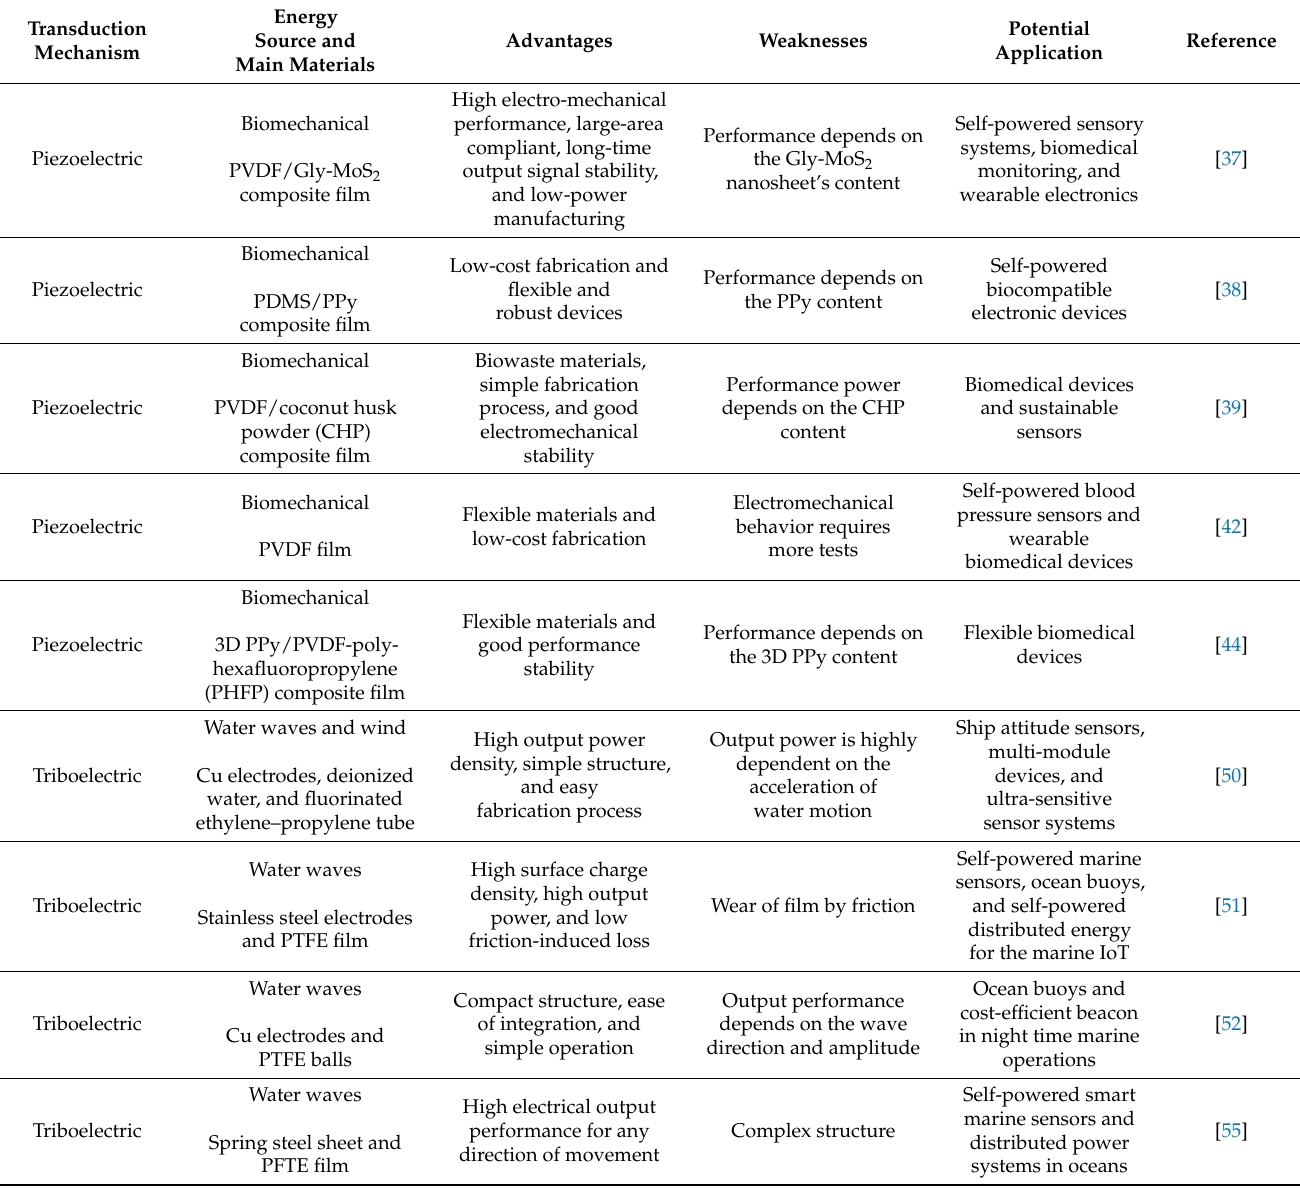
Table 1 reported the comparison of the main characteristics of various nanogenerator types, including the transduction mechanism, energy source, materials, advantages, and weaknesses. For a single transduction mechanism, the triboelectric nanogenerators have important characteristics such as high electrical output performance, good stability, simple structure, and cost-efficient fabrication. In addition, this nanogenerator can be designed to convert different energy sources (e.g., biomechanical, water waves, environmental vibrations, and wind) into electrical energy. On the other hand, the hybrid nanogenerators present an enhanced electrical output performance in comparison with nanogenerators based on a single transduction mechanism. The hybrid nanogenerators that include the triboelectric effect have the best operation parameters such as compact and simple structure, good flexibility, stability, low-cost manufacturing, and high electrical output performance. Table 1. Summary of the main characteristics of several nanogenerators used to harvest different green energy